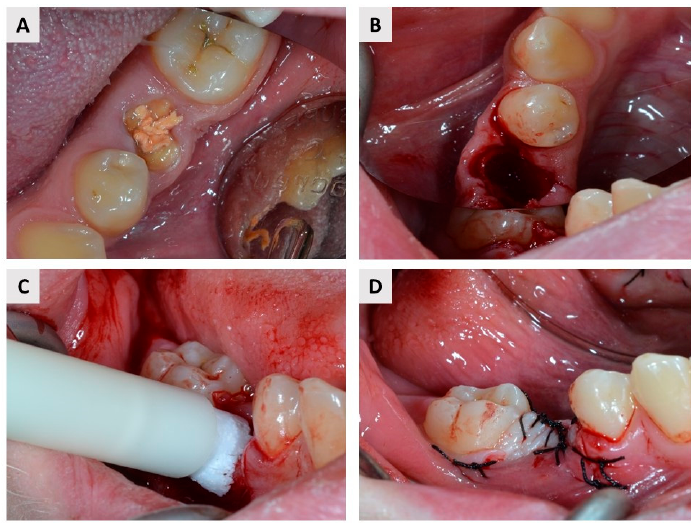
Figure 2. ( A ) Occlusal photograph of a root without a crown (lat. radix relicta ) that was predisposed to extraction. ( B ) Alveolar socket following atraumatic extraction and curettage. ( C ) Application of maxresorb ® inject. ( D ) Complete coverage of the biomaterials (IBCP and resorbable membrane) was achieved with single 5/0 sutures.